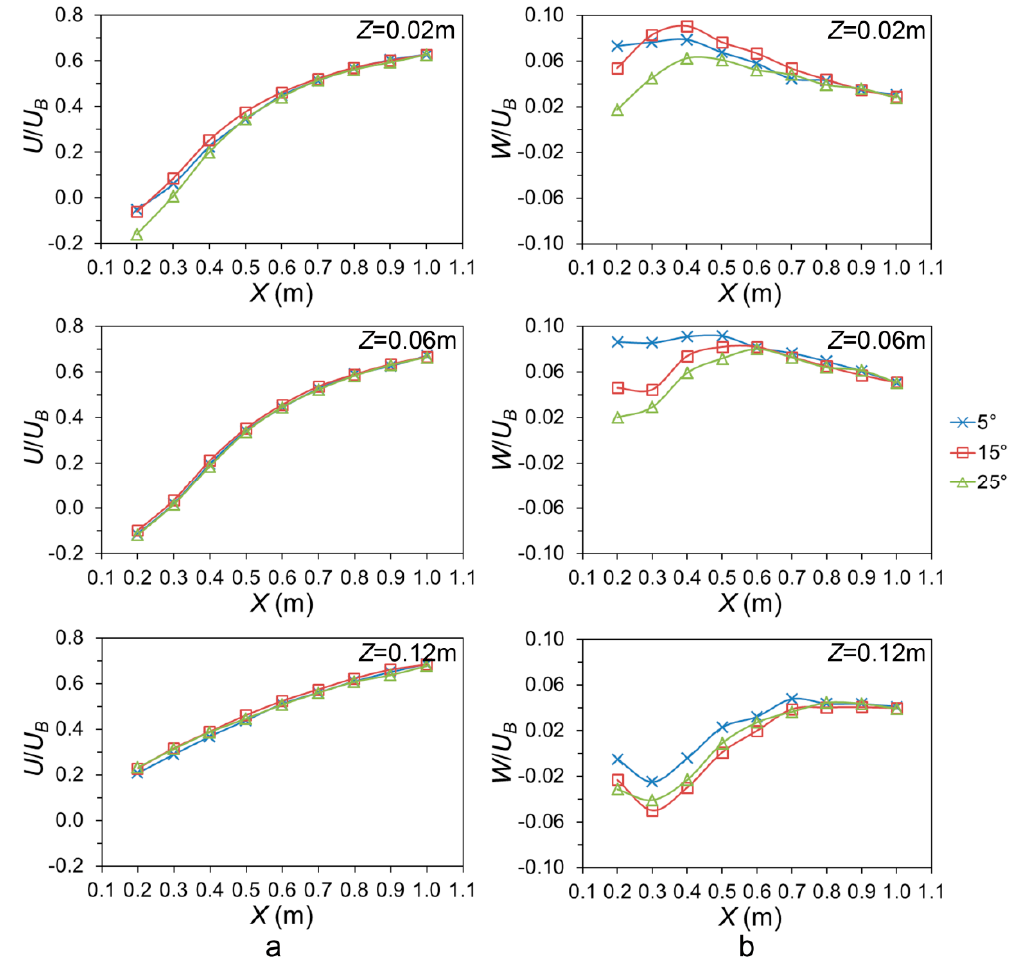
Figure 10. Variations of normalised streamwise air velocity U / U B ( a ) and vertical air velocity W / U B ( b ) with respect to the distance from the building ( X ) at heights ( Z ) of 0.02 m, 0.06 m, and 0.12 m for roof slopes of 5°, 15°, and 25°. U B is the streamwise air velocity at the building height.